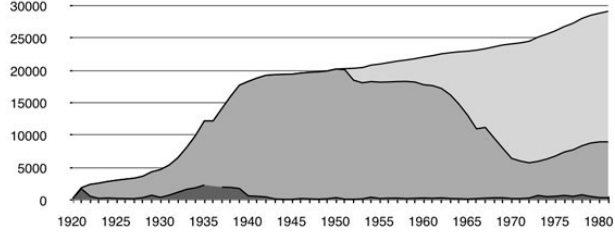
Fig. 5. Hectares of drainage systems yearly erected in the Kronoberg County 1920 to 1982. Data on drainage areas for which government grants have been given for the year they have been inspected. Before 1920 quantitative data is rare. Data displayed as yearly addition, cumulative over 30 years, and cumulative over the whole period. Source: annual reports from the Swedish Forest Agency